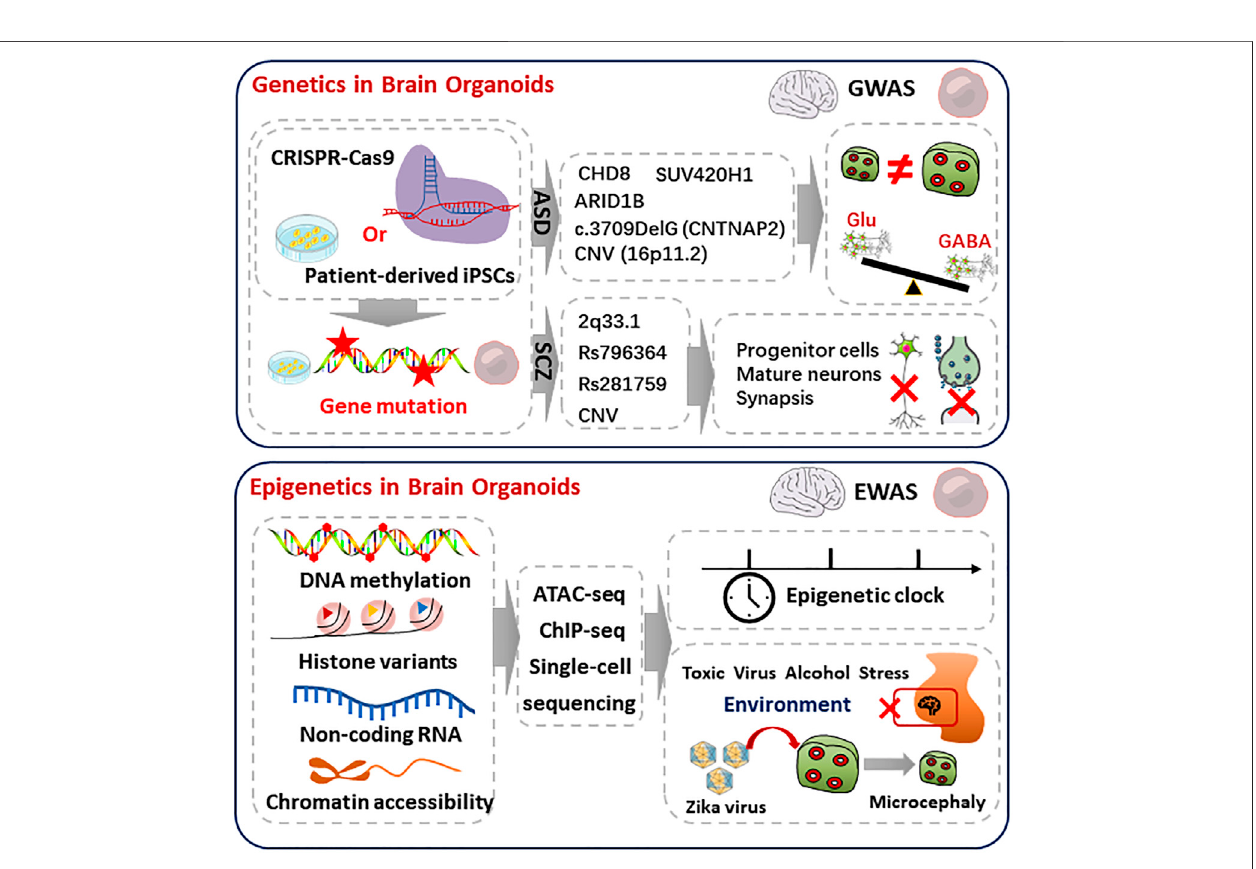
FIGURE 2 | Reality of brain organoids in simulating human brain. Brain organoids and region-speci fi c brain organoids were induced by undirected or directed differentiation, respectively. Single-cell sequencing and transcriptome analysis was performed to characterize the similarity of cellular composition and gene expression in brain organoids and human brain. Multi-electrode arrays detected the electrophysiological signals of cortical brain organoids that is similar to EEG signals in preterm infants